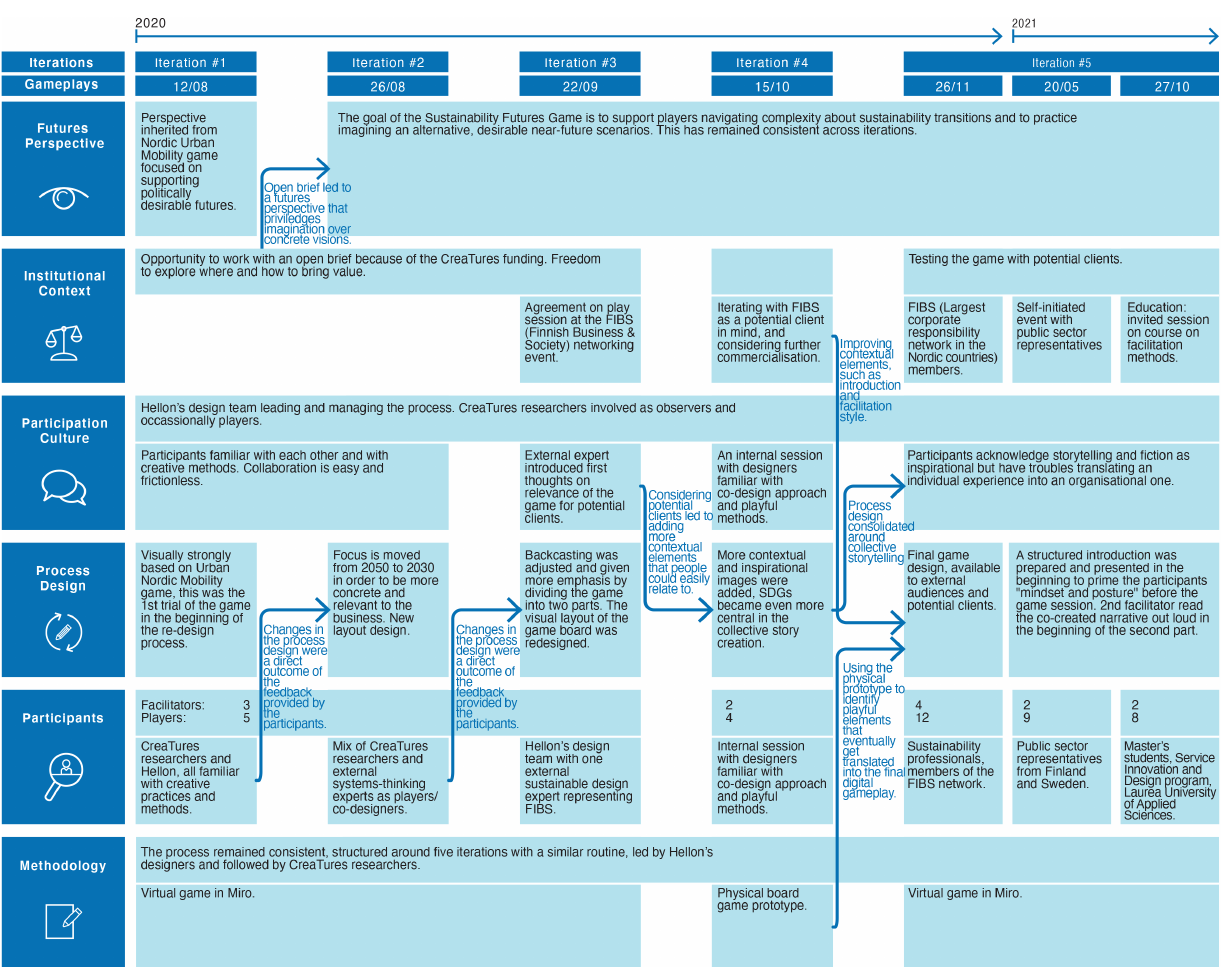
Figure 2. Development process of the Sustainability Futures Game following the framework by Mangnus (2022). such as simplifying some of the tasks to better fit story creation purposes and adding two new tasks to cater to potential new business